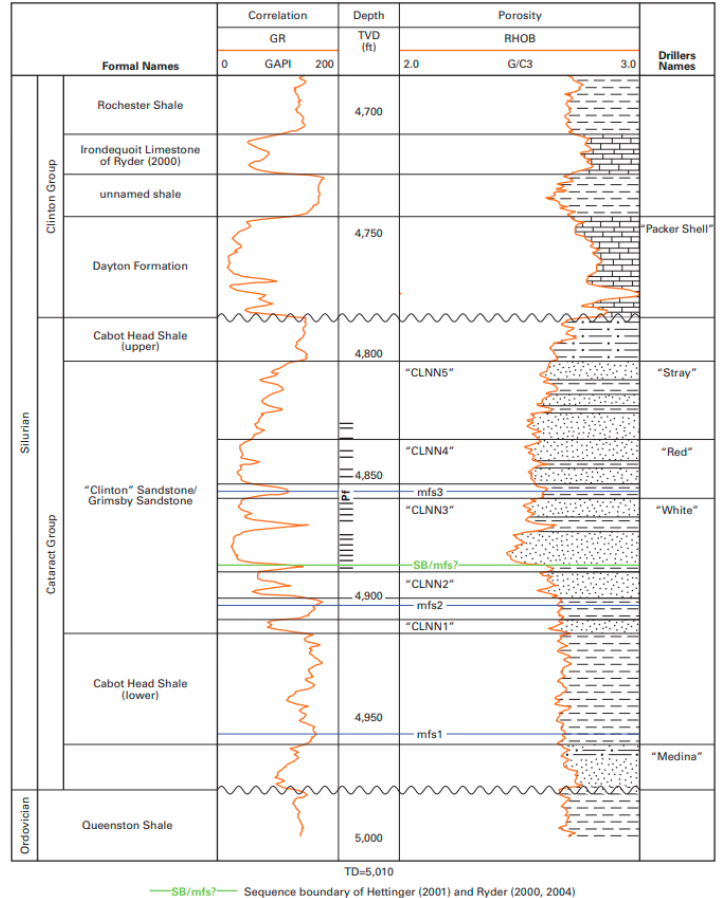
Figure 5. Typical well log in ECOF showing major members of Clinton dolomite [14].